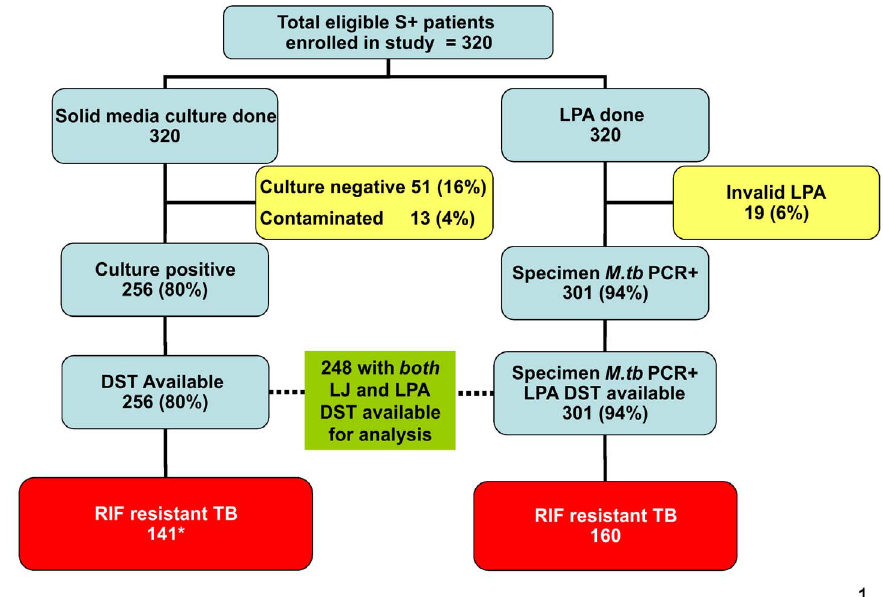
Figure 1. Suspect enrolment and result summary. doi:10.1371/journal.pone.0088626.g001 PLOS ONE |